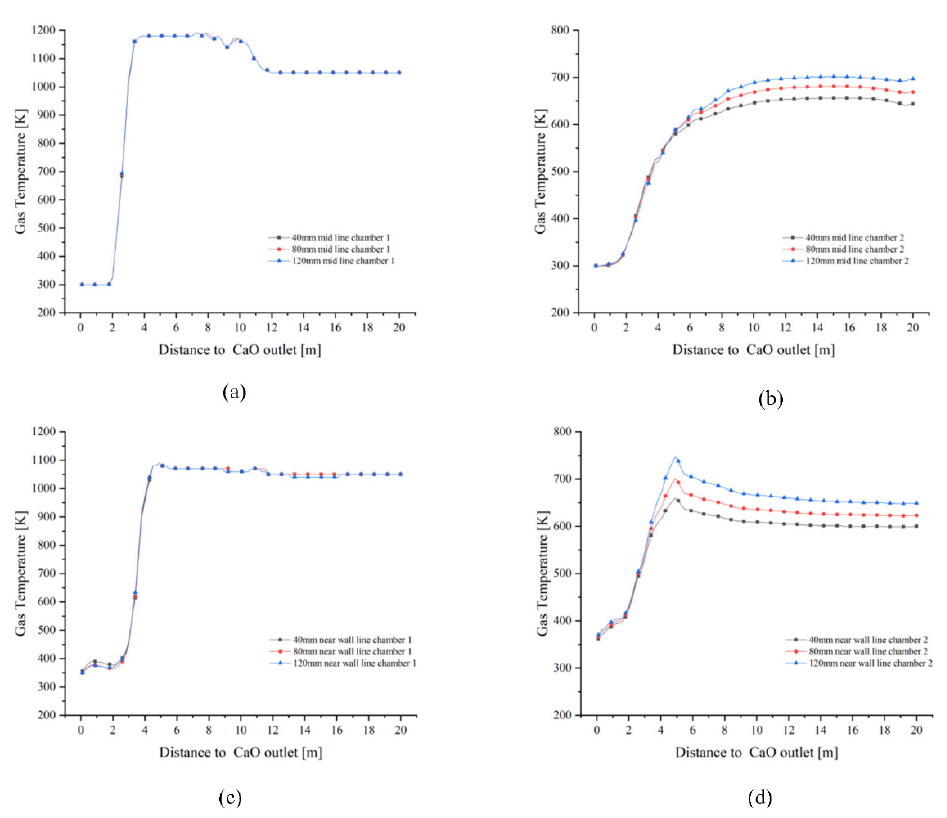
Figure 8. Comparison of gas temperature variations in the mid line and near wall line of chamber 1 and 2. ( a ) Change in gas temperature at the mid line of chamber 1; ( b ) Change in gas temperature at the mid line of chamber 2; ( c ) Change in gas temperature at the near wall line of chamber 1; ( d ) Change in gas temperature at the near wall line of chamber 2.